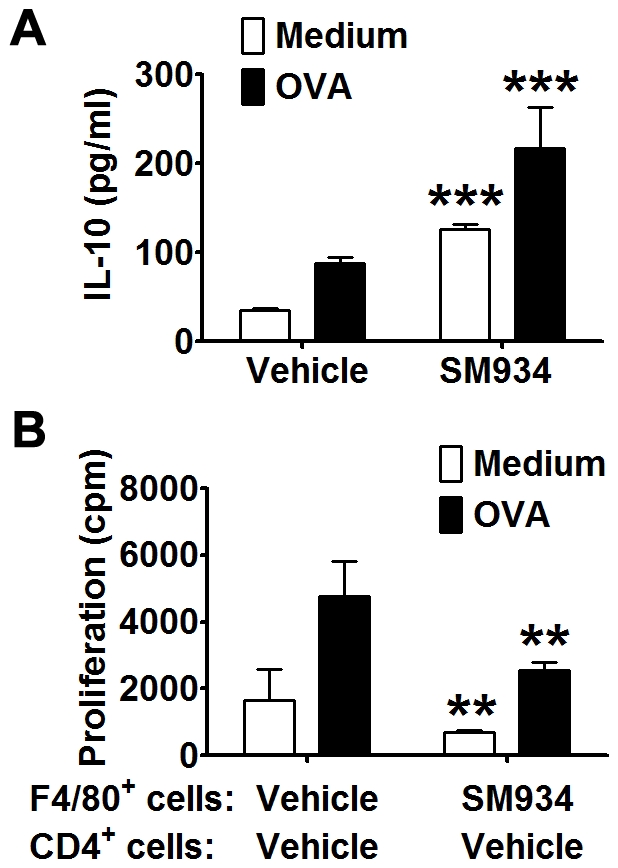
SM934 treatment induced IL-10 production of macrophages in OVA-immunized mice.Naïve female C57BL/6 mice were immunized with OVA/CFA and treated with vehicle or SM934 (10 mg/kg) for consecutive 7 days (9 mice per treated group). At the termination of treatment, both groups were randomly and averagely divided into 3 sub-groups. Spleens of each sub-group were pooled together. (A) IL-10 production in splenocytes cultured with OVA recall for 24 hours. (B) OVA-induced proliferation in CD4+ T cells from vehicle treated mice co-cultured with macrophages from vehicle or SM934 treated mice for 72 hours. Bars showed the mean ± SD. ** = P<0.01, *** = P<0.001 versus corresponding medium or vehicle control with similar stimulatory condition.